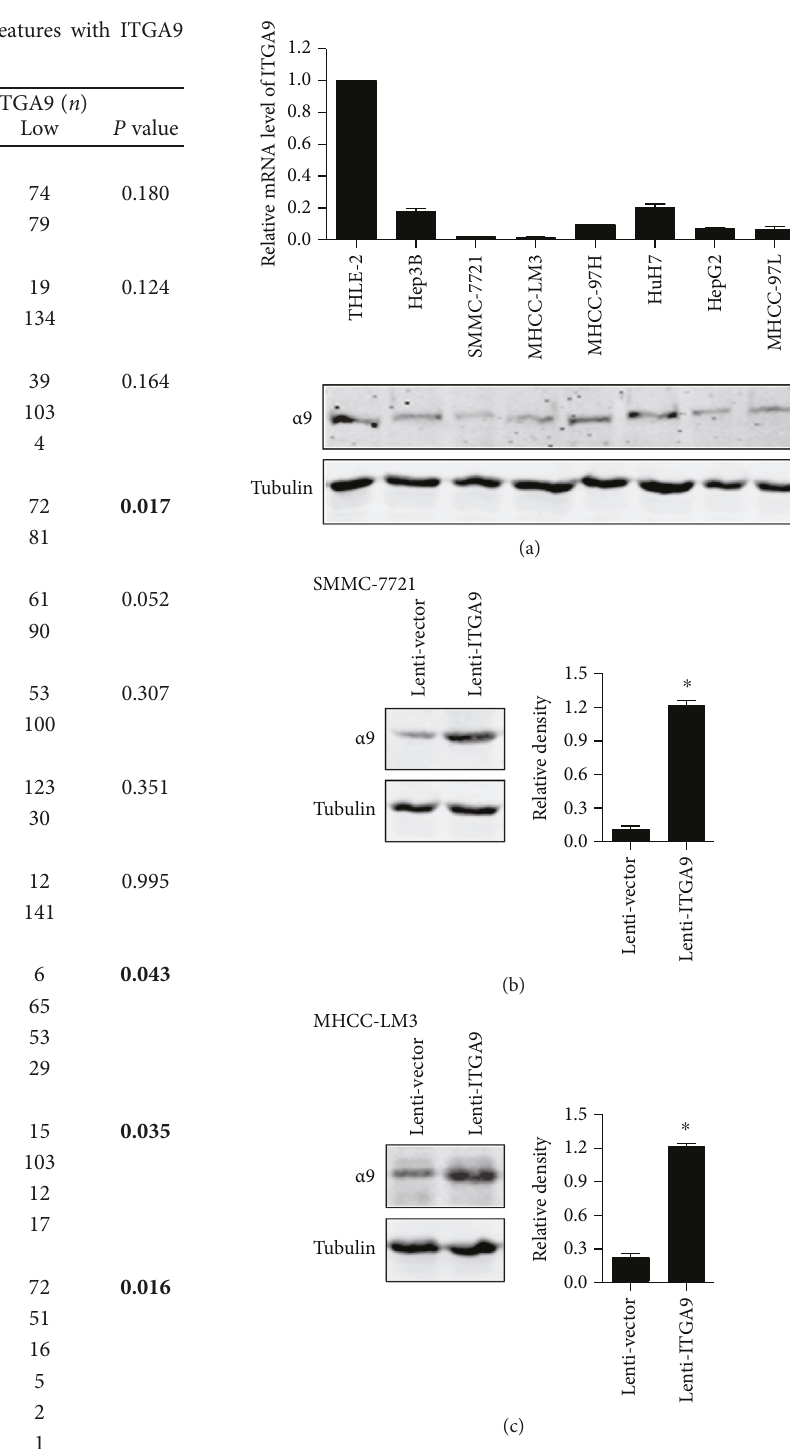
Figure 2: Analysis of ITGA9 expression in cell lines. (a) ITGA9 levels in 7 HCC cell lines and the immortalized human liver cell line THLE-2 as measured by qPCR and Western blot. (b and c) Expression of ITGA9 in SMMC-7721 and MHCC-LM3 cells with Lenti-vector or Lenti-ITGA9. Tubulin was used as an internal control. Values are means ± SEM. ∗ P < 0 05 .